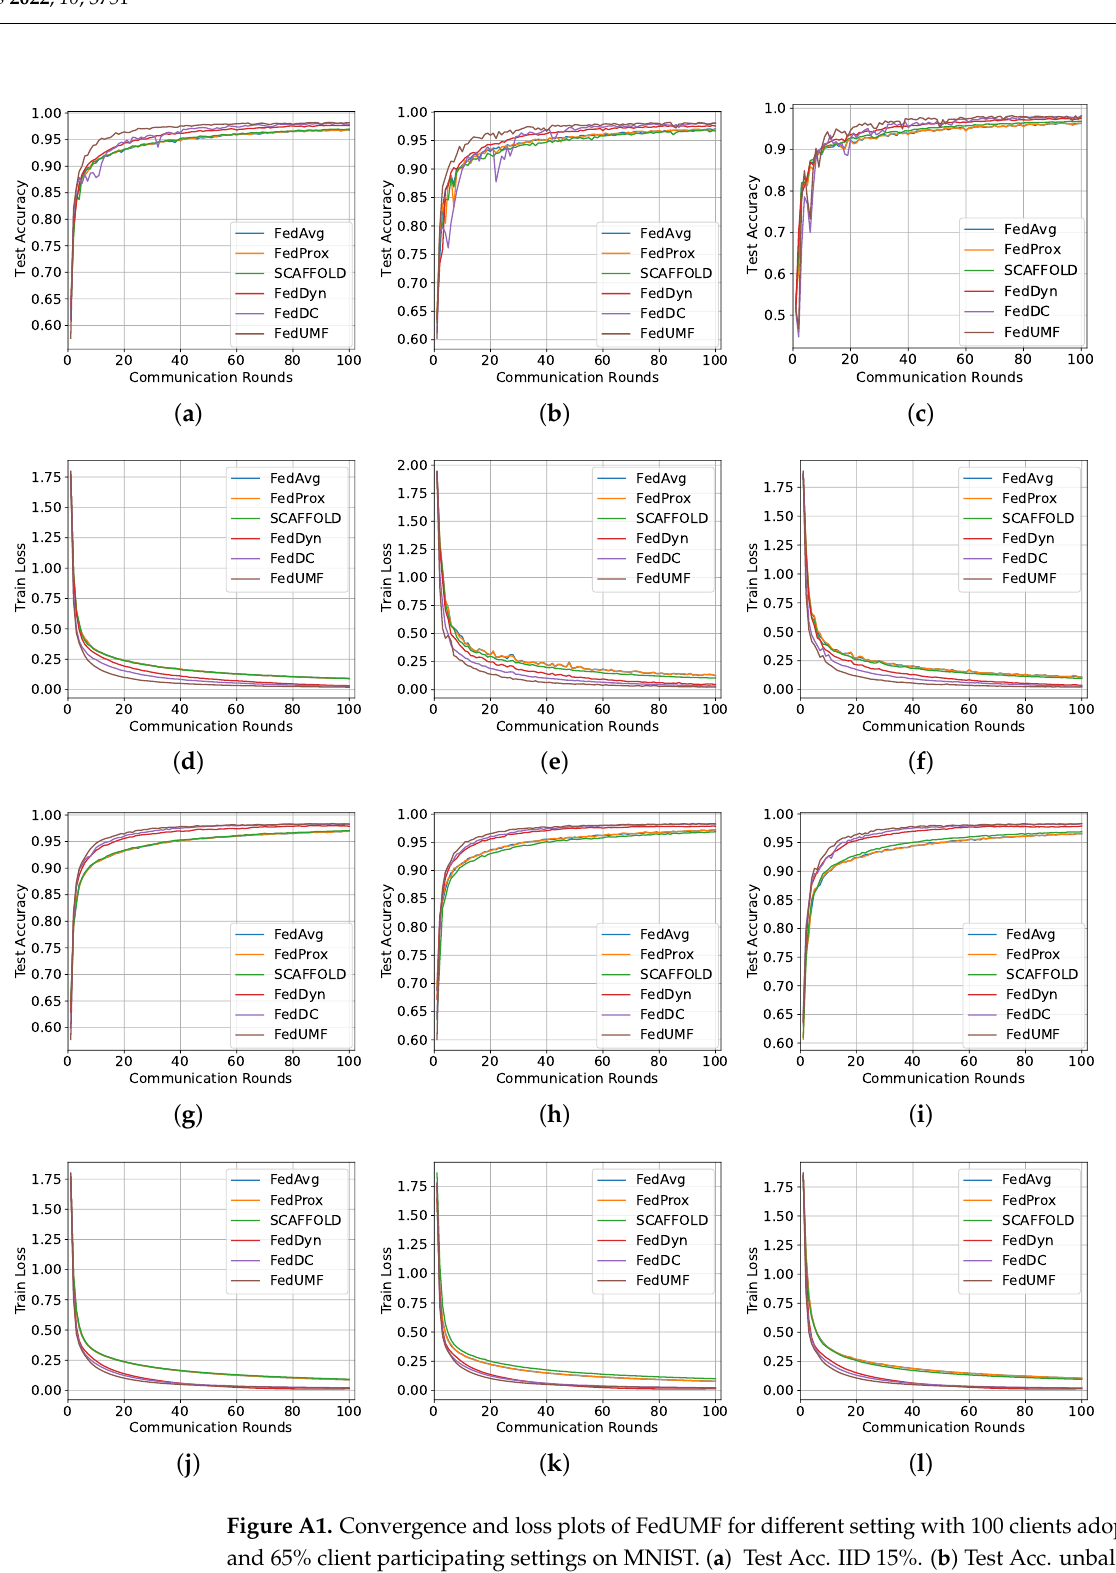
Figure A1. Convergence and loss plots of FedUMF for different setting with 100 clients adopting 15% and 65% client participating settings on MNIST. ( a ) Test Acc. IID 15%. ( b ) Test Acc. unbalance 15%. ( c ) Test Acc. Drichlet 0.6 15%. ( d ) Train Loss. IID 15%. ( e ) Train Loss. Drichlet 0.3 15%. ( f ) Train Loss. Drichlet 0.6 15%. ( g ) Test Acc. IID 65%. ( h ) Test Acc. unbalance 65%. ( i ) Test Acc. Drichlet 0.6 65%. ( j ) Train Loss. IID 65%. ( k ) Train Loss. unbalance 65%. ( l ) Train Loss. Drichlet 0.6